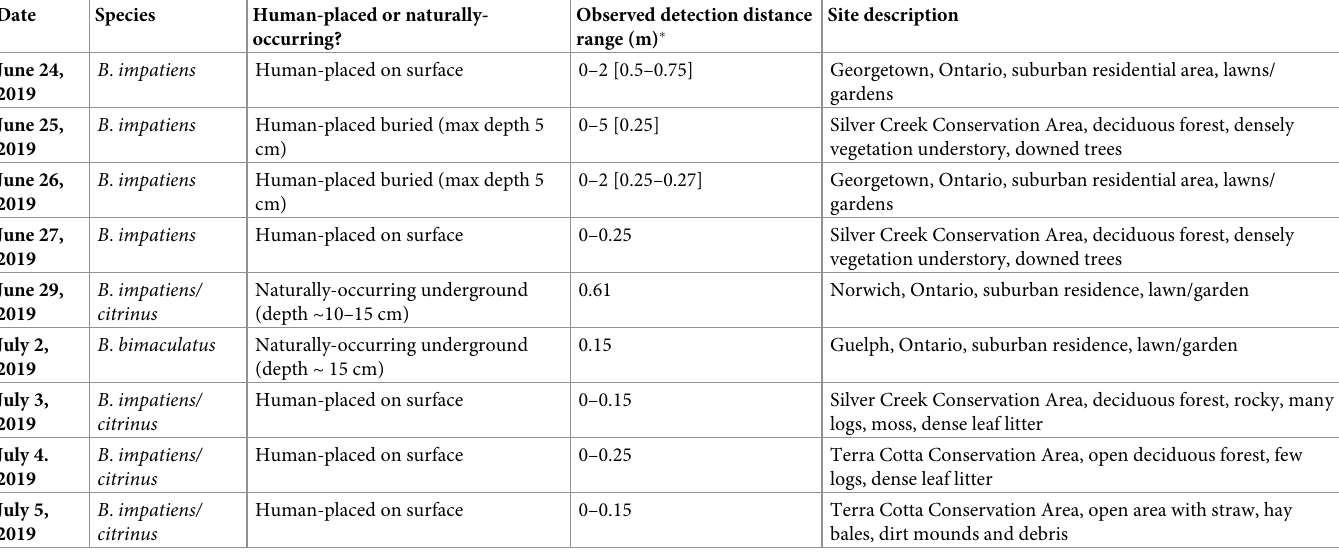
Table 2. Detection distances observed for human-placed material and naturally-occurring bumble bee ( Bombus spp.)